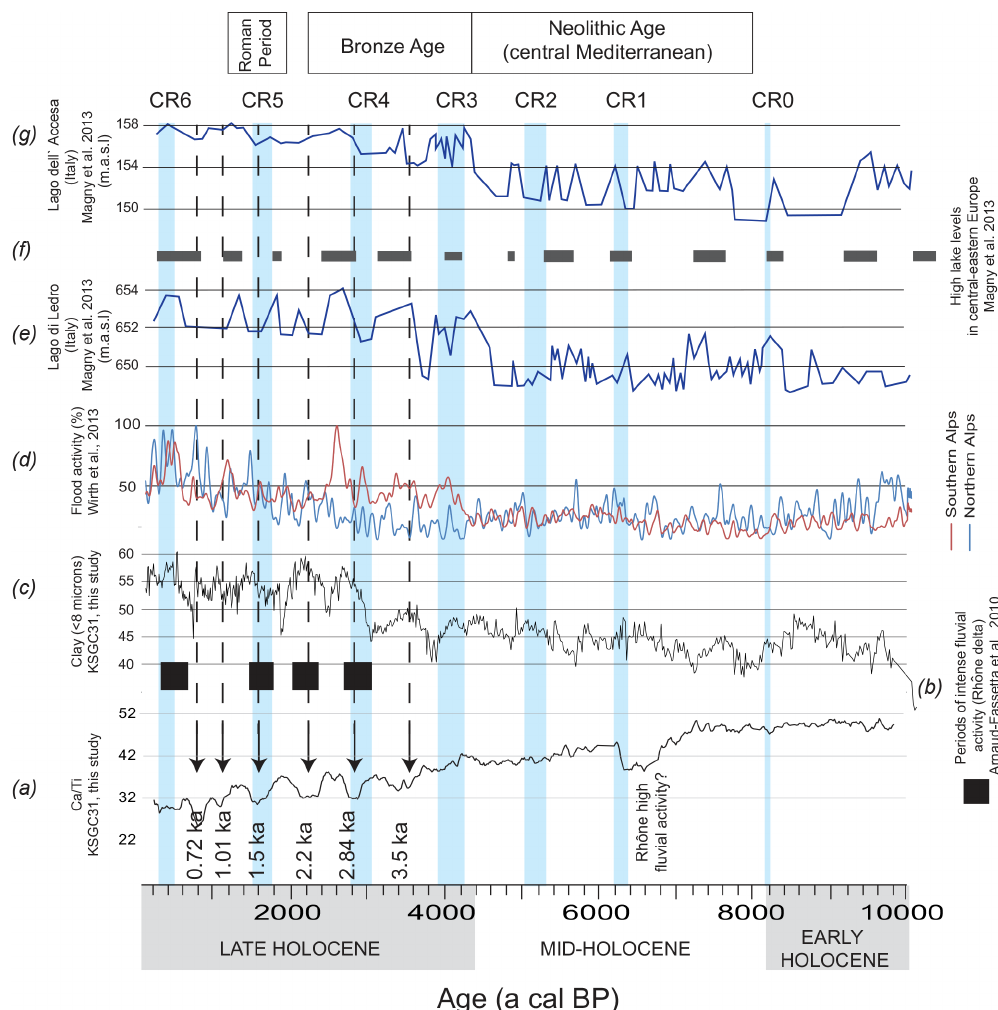
Figure 5. Ca / Ti ratio (a) and percentage of fine-grained (<8µm) sediment (c) compared to (b) periods of intense fluvial activity based on hydromorphological and paleohydrological changes in the Rhône Delta (Arnaud-Fassetta et al., 2010). (d) Holocene flood frequency (%) in southern and northern Alps estimated on the basis on lake flood records by Wirth et al. (2013). (e–g) Lake level fluctuations in central and eastern Europe during the Holocene (Magny et al., 2013). Blue bands correspond to CR0-6 chronology; dotted black lines highlight the main wet events that may be observed in sediment records in the late Holocene (Table 3).